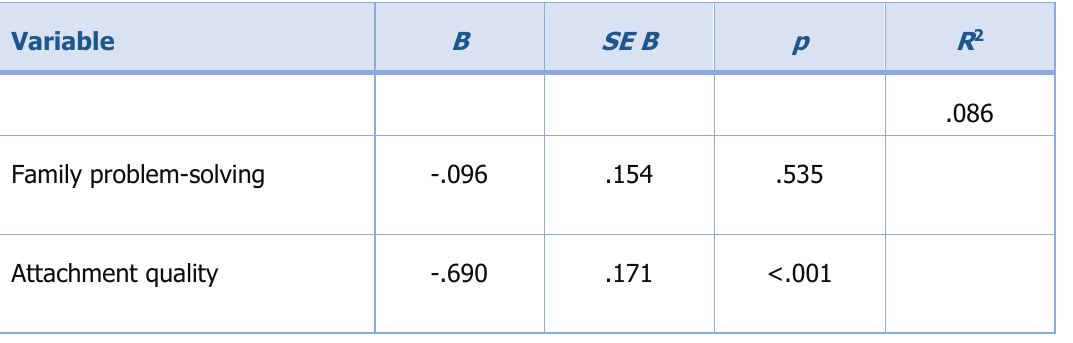
Table 4. Path Model Summary for Family Problem-Solving and Attachment Quality Predicting Youth-Reported Risk-Taking (N =